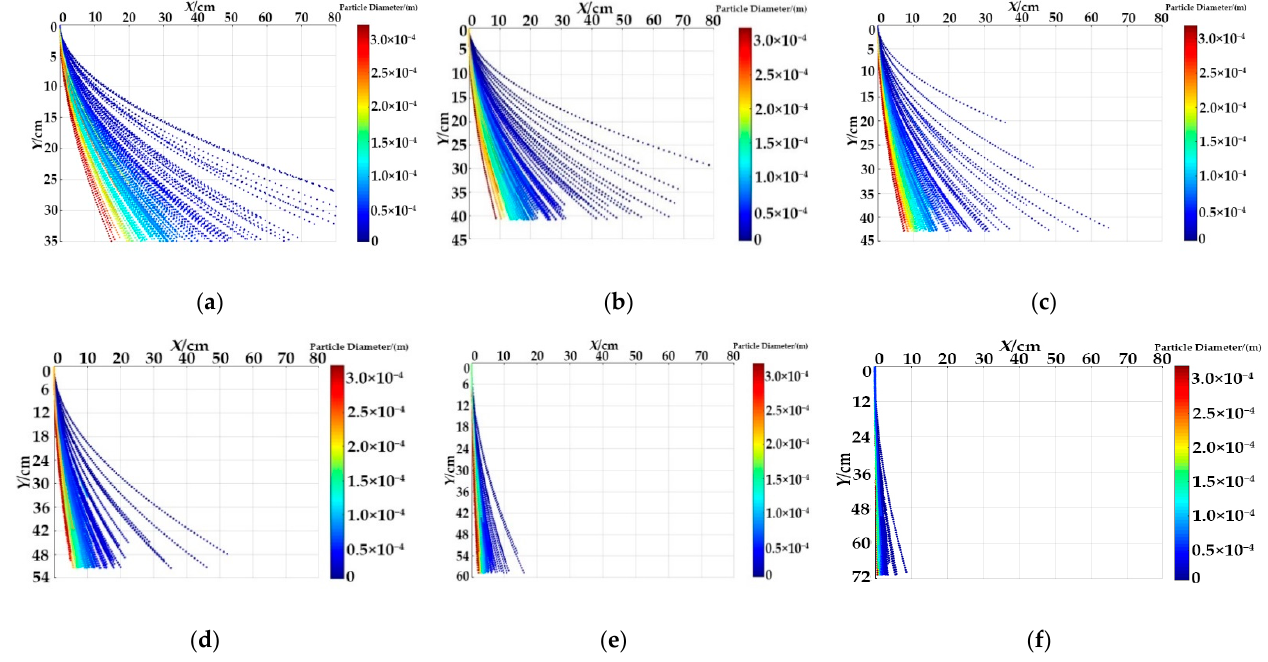
Figure 8. Droplet distributions on the reference surface with different V-shaped wind speed: 15 m/s ( a ); 17.5 m/s ( b ); 20 m/s ( c ); 22.5 m/s ( d ); 25 m/s ( e ); 27.5 m/s ( f ).